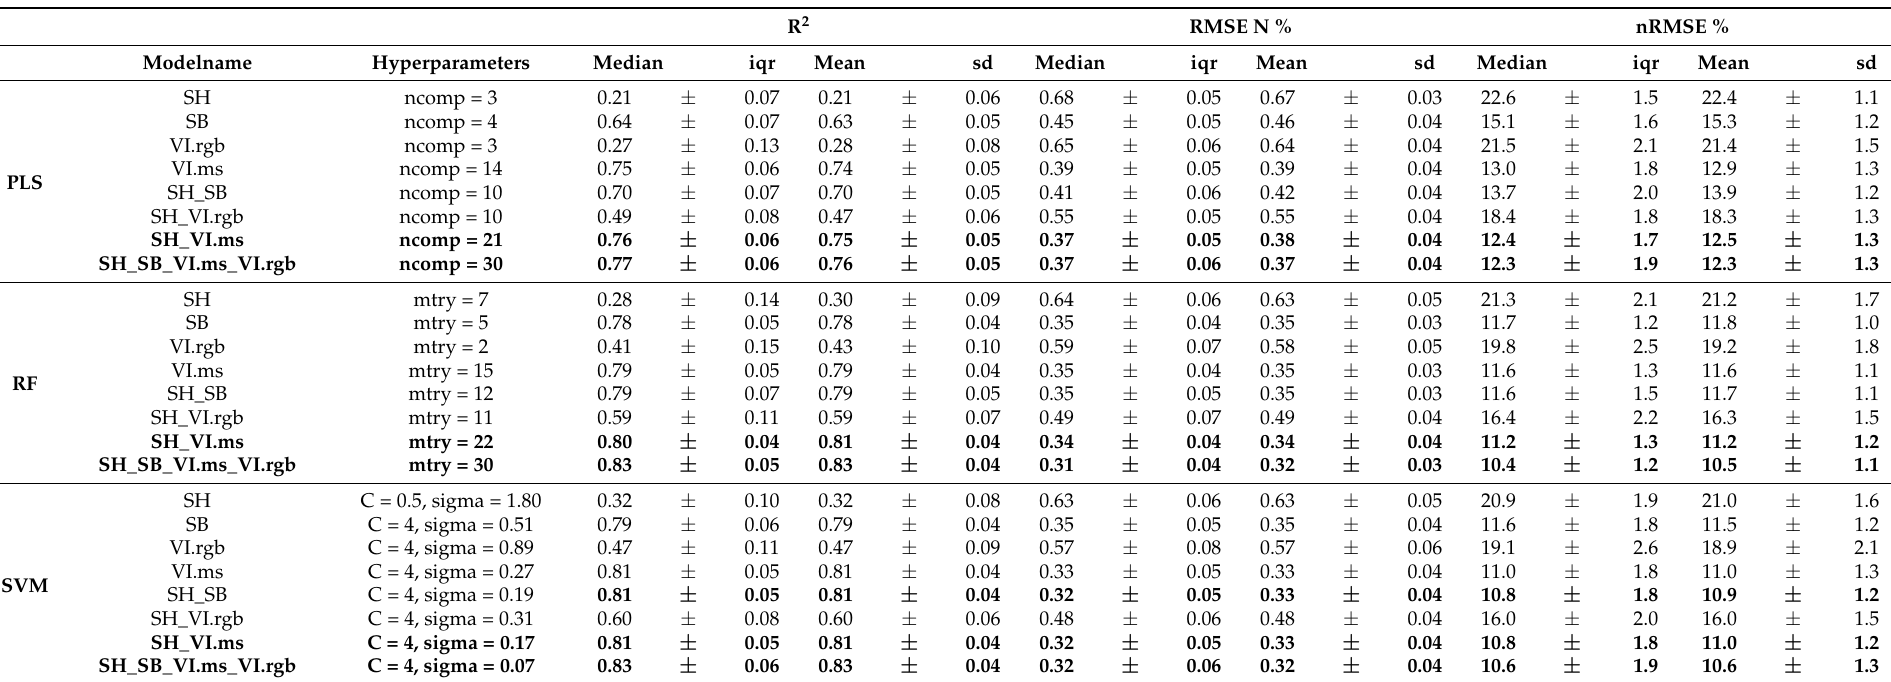
Table A3. Cross-validation results for N% estimation using PLS, RF and SVM regression (nRMSE normalized via mean observed value). Bold highlights indicate two best models per algorithm. iqr: interquartile range, sd: standard